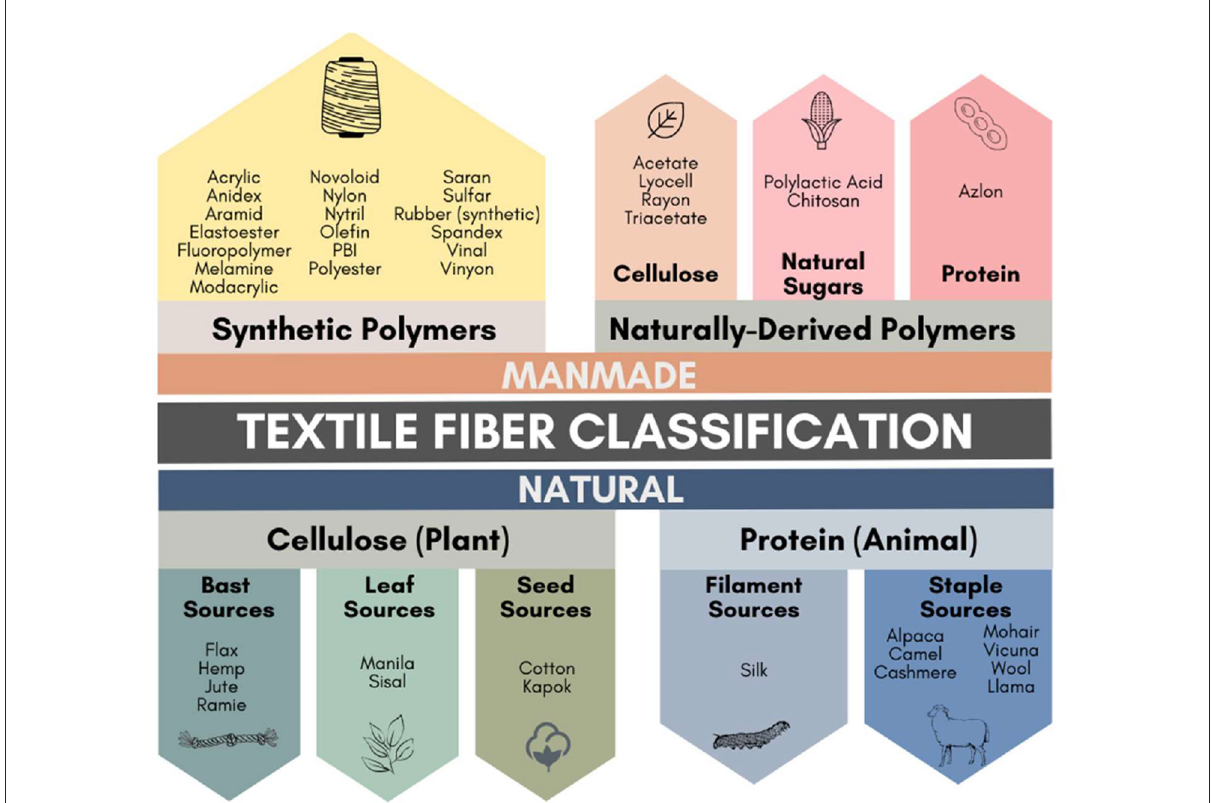
FIGURE1 Classification by fiber type [as defined in Morton and Hearle (2001); Code of Federal Regulations (2022)].